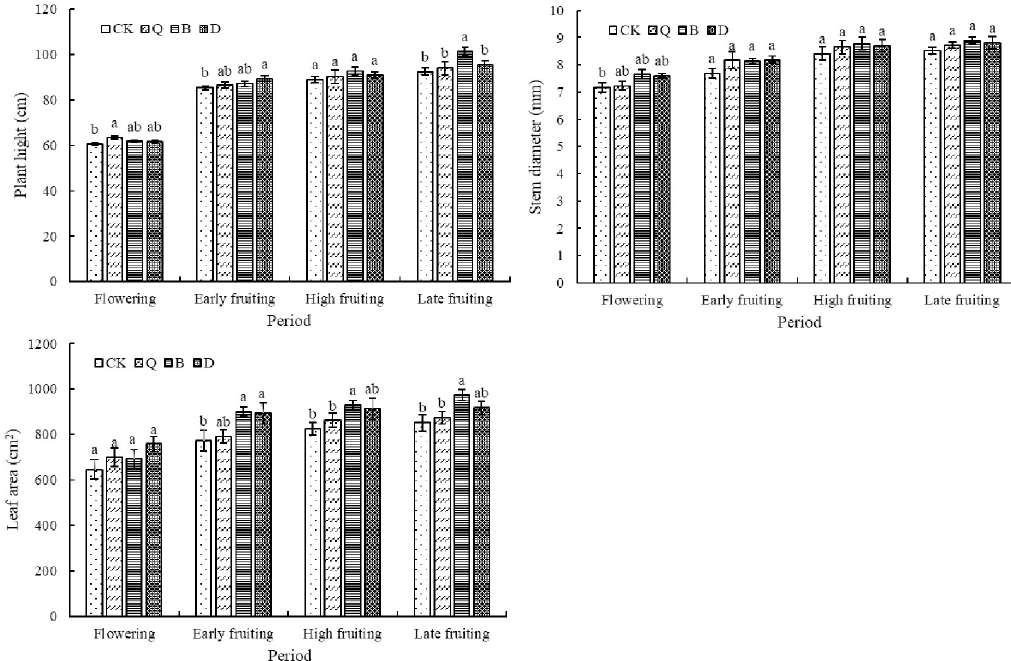
Fig 4. Effects of different vegetable rotations on tomato plant growth. CK: Continuous tomato cropping; Q: Celery/tomato rotation; B: Cabbage/tomato rotation; D: Kidney bean/tomato rotation. Different lowercase letters at each phenological stage indicate that the differences are statistically significant (P <